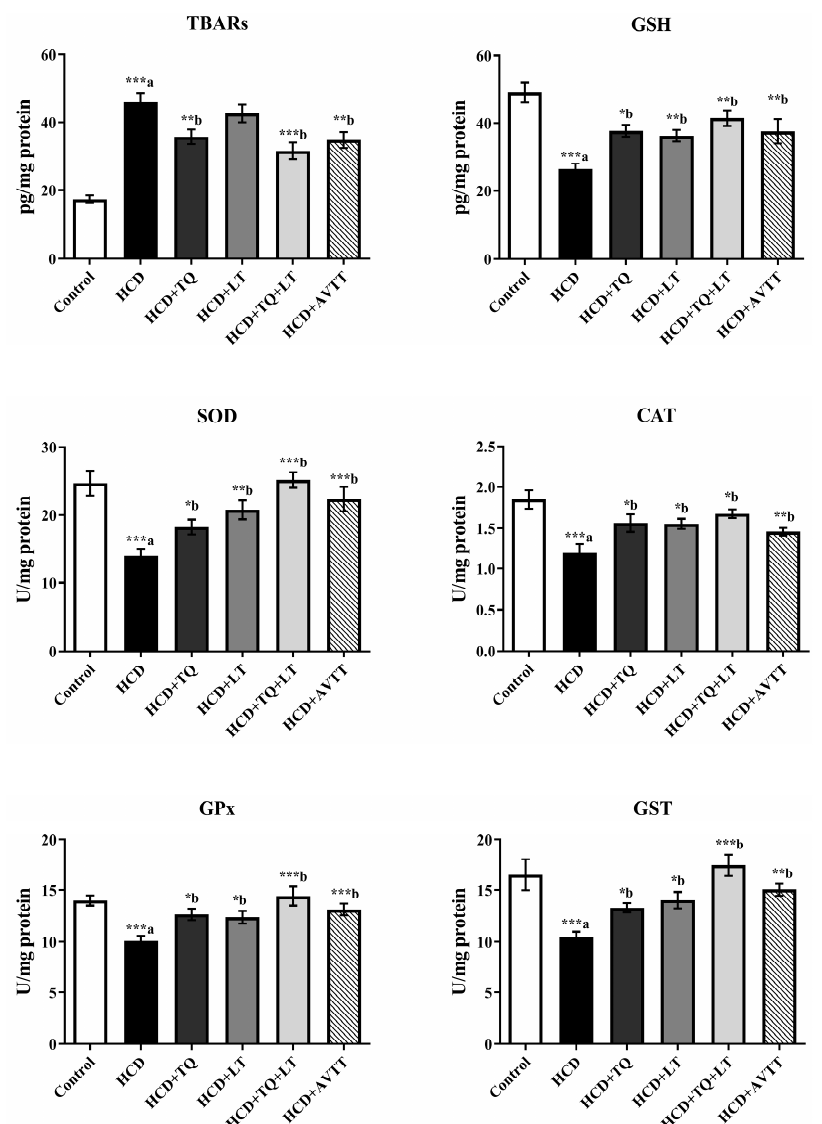
Figure 6. Effect of thymoquinone (TQ), losartan (LT) and their combination on high cholesterol diet (HCD)-induced changes in cardiac tissues levels of oxidative parameters including TBARs, GSH, SOD, CAT, GPx and GST. Data are expressed as Mean ± SE (n = 6) and analyzed using one-way ANOVA followed by Student–Newman–Keuls as post hoc test. a Control vs. HCD group; b HCD vs. QT or LT or QT + LT. p values considered significant when * p < 0.05, ** p < 0.01 and *** p < 0.001. The heart tissues of both the control and treatment groups were subjected to